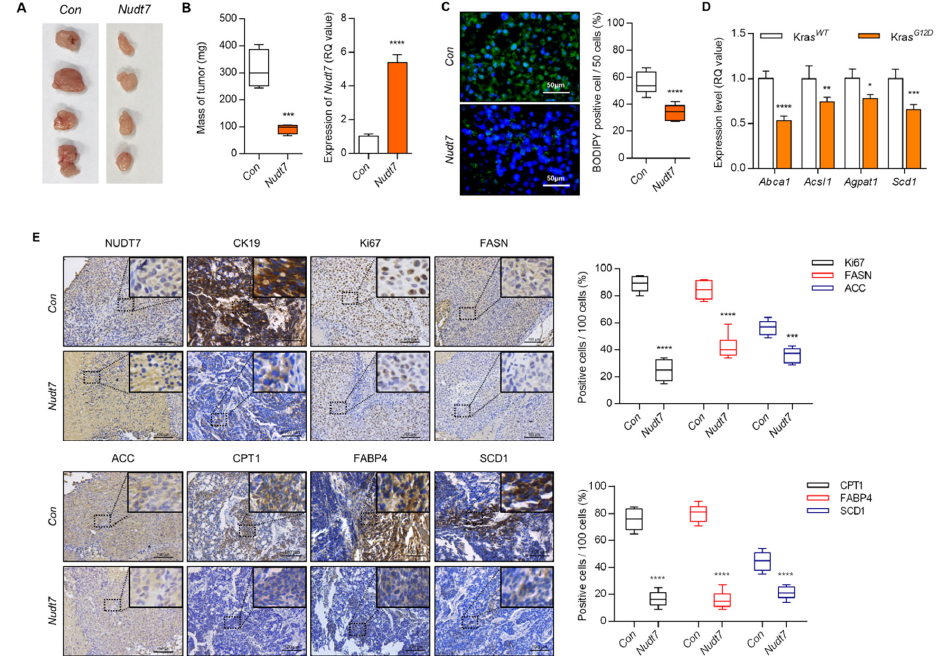
Figure 3. Nudt7 is involved in the progression of Kras G12D CRC. ( A,B ) Cells transduced with lentivirus containing the control and Nudt7 in LS174T cells were grafted into nude mice. Each tumor mass was measured and the expression level of Nudt7 was confirmed by real-time PCR and is presented as the fold change compared with the control (Con). Results are representative of at least 4 independent experiments. ( C ) BODIPY staining in control and Nudt7 -grafted tumors, and BODIPY-positive cells were counted for every 50 cells in 3 different fields. Results are representative of at least 3 independent experiments. Scale bars: 50 μm. ( D ) Expression level of lipid metabolic genes and presented as the fold change compared with Con. Rn18s was used as an endogenous control. Results are representative of at least 3 independent experiments. ( E ) Immunohistochemical staining with cytokeratin 19 (CK19), Ki67, FASN, ACC, CPT1, FABP4, and SCD1. CK19 was used as a marker for epithelial tissue. Positive cells were counted for every 100 cells in 3 different fields at 200 × magnification. Results are representative of at least 3 independent experiments. The dotted line boxes were enlarged in the upper right corner of each image. Scale bars: 100 μm. Values are means + SD. An unpaired Student’s t -test was used for statistical analysis. * p ≤ 0.05, ** p < 0.01, *** p < 0.001, **** p < 0.0001.